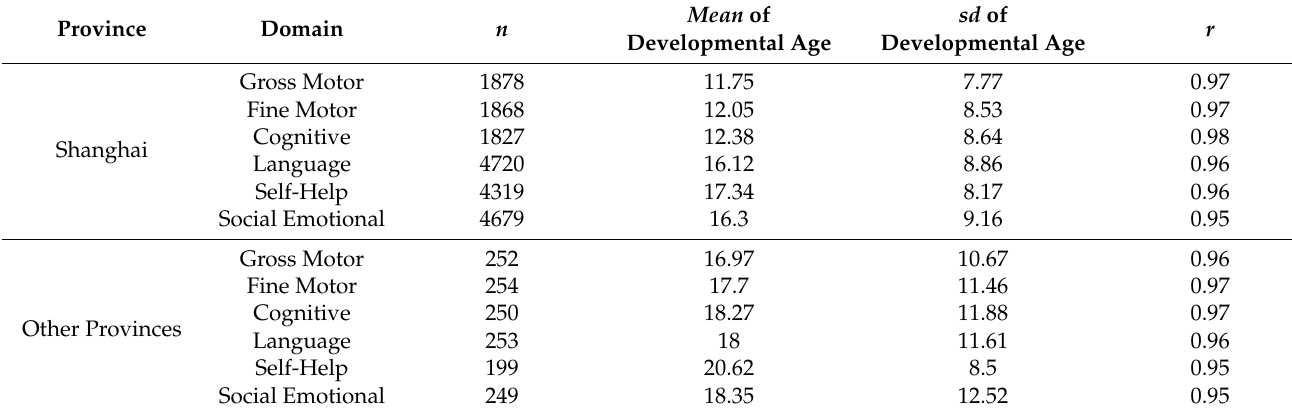
Table 3. Pearson correlation coefficients between developmental age and chronological age from 2016 to 2019 by province. Province